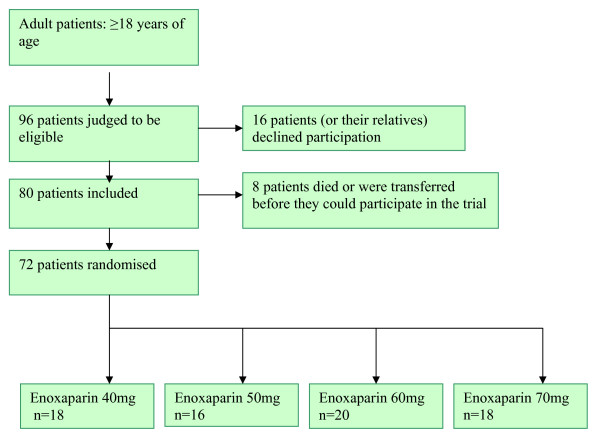
Consort diagram.